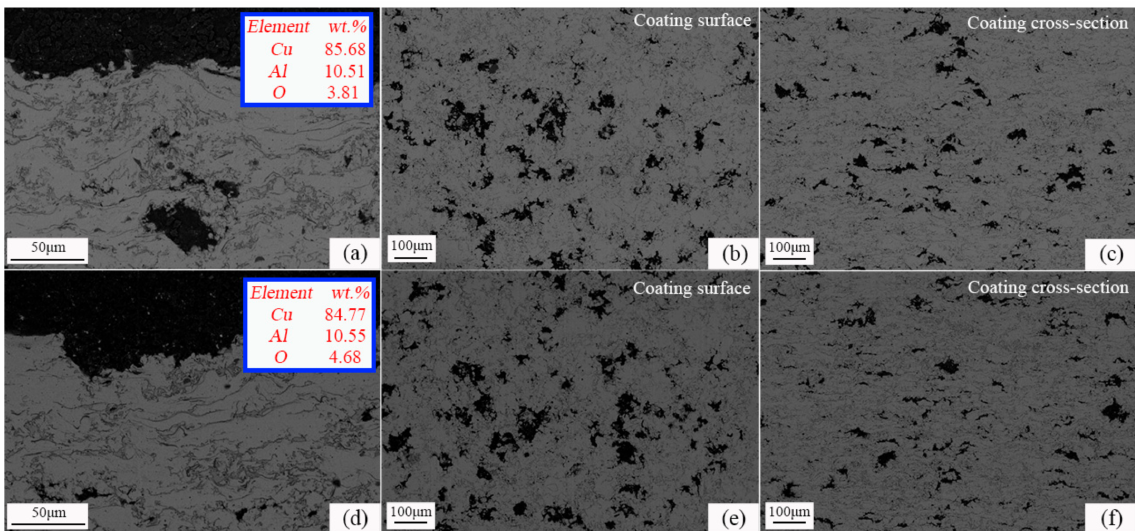
Figure 13. Microstructure and pore distribution of the CuAl seal coatings under constant temperature oxidation at 600 ◦ C for ( a – c ) 500 h; ( d – f ) 1000